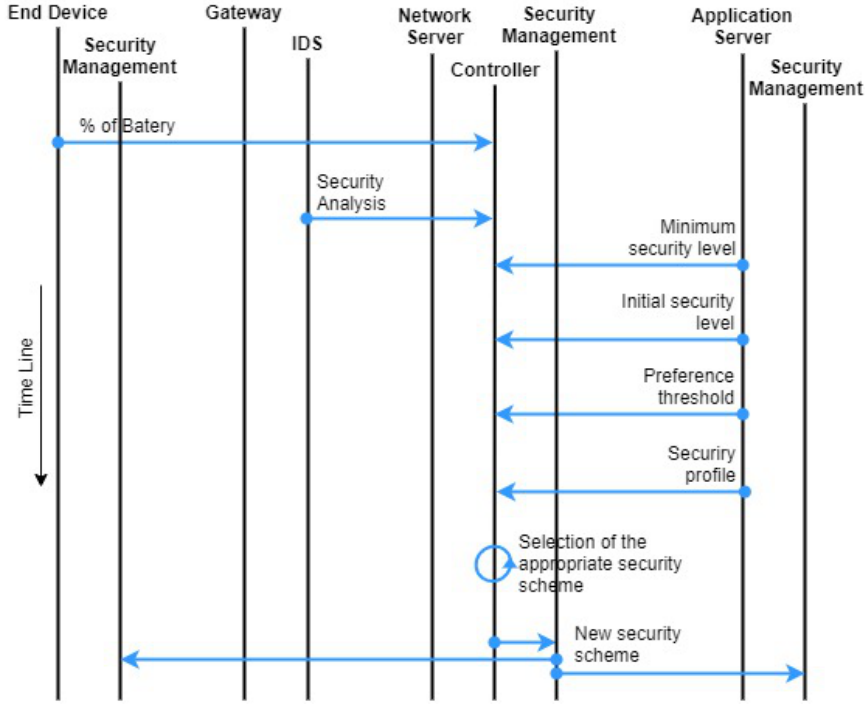
Figure 4. Operational phase the proposed architecture (protocol